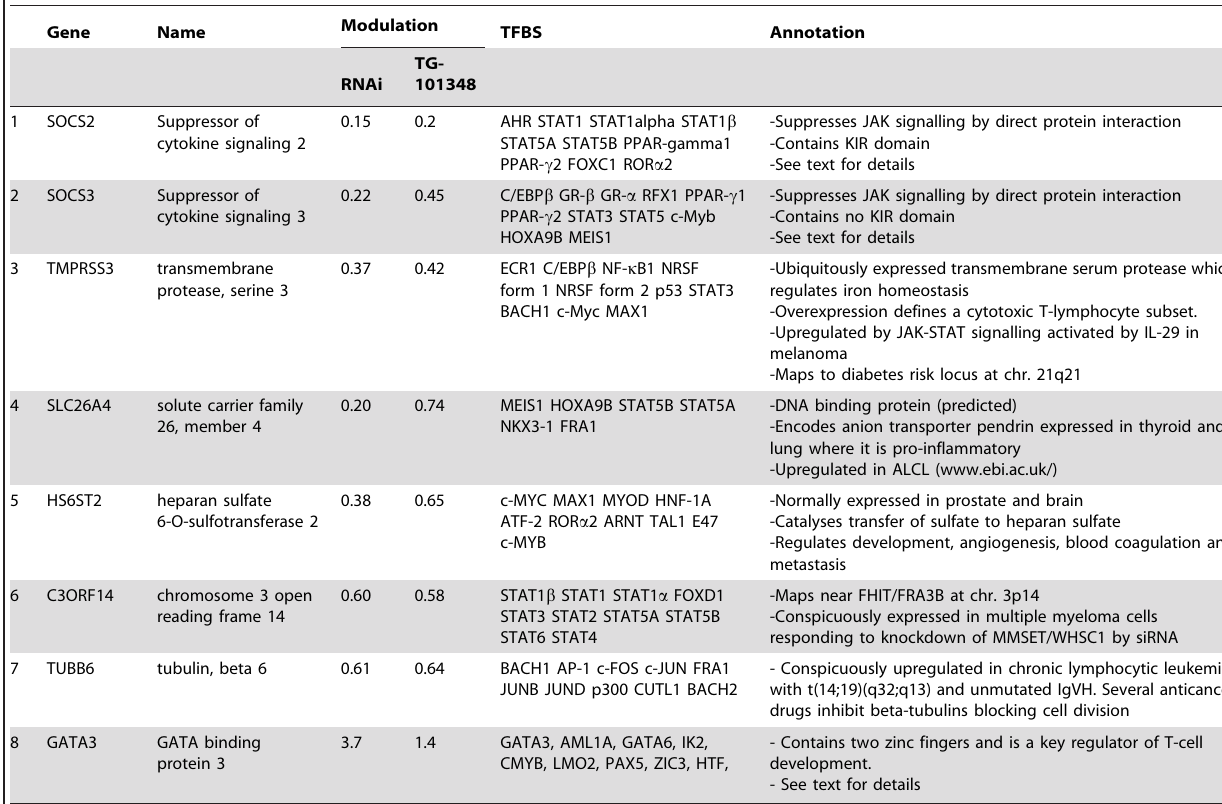
Table 2. Top PCM1-JAK2 transcriptional target